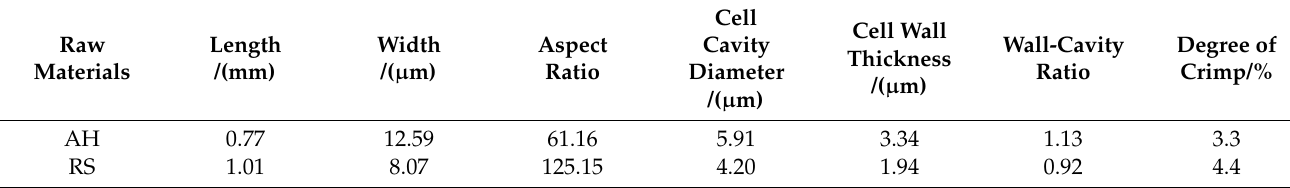
Figure 1. Morphological micrographs of areca nut husk and rice straw. ( a ) 100× micrograph of areca nut husk fiber morphology; ( b ) 100× micrograph of rice straw fiber morphology; ( c ) 400× micrograph of areca nut husk fiber morphology; ( d ) 400× micrograph of rice straw fiber morphology. Table 2. Fiber morphologies of areca nut husk and rice straw.